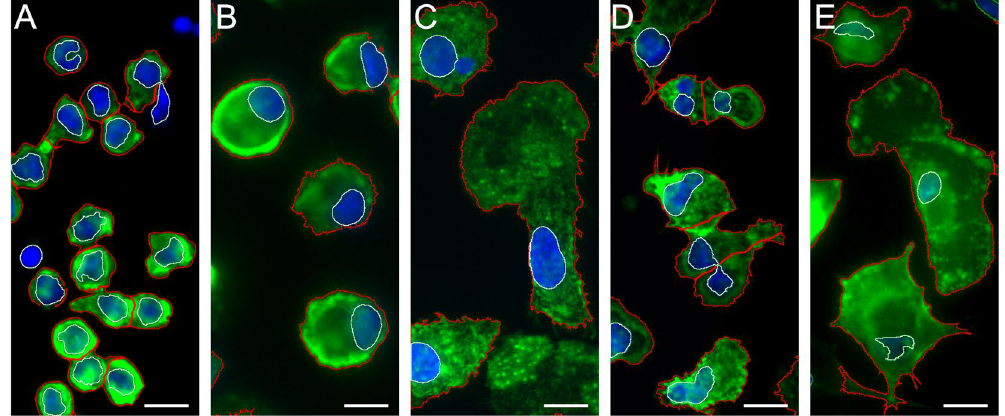
Figure 4. Immunofluorescent staining of monocytes and macrophages. ( A ) Monocytes cultured for 2 h; ( B ) monocytes cultured for 6 days; ( C ) naïve macrophages; ( D ) M1 macrophages; ( E ) M2 macrophages. F-actin and cell nuclei were stained with Phalloidin Alexa Fluor 488 (green) and DAPI (blue), respectively. The detected nucleus and cell outlines are shown as green and red lines respectively. Scale bar = 10 µ m. Representative images from n = 6 are presented.